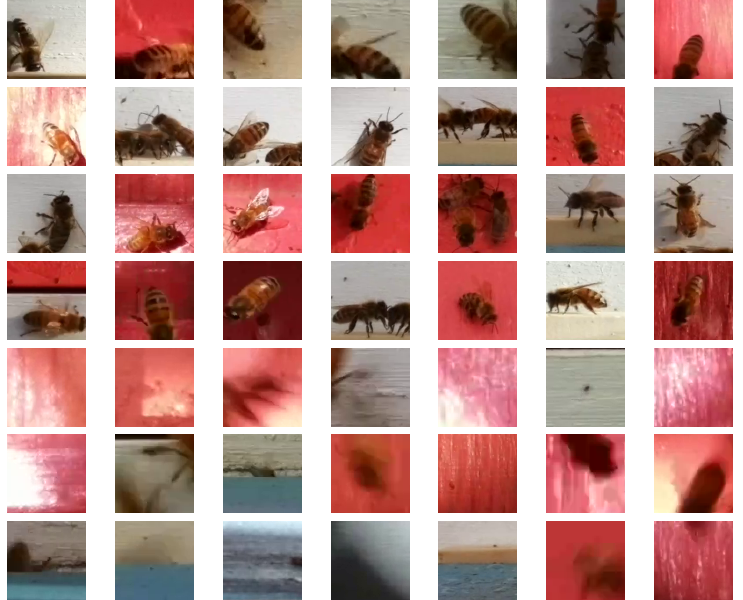
Figure 6. Sample of 1-super images from BEE2 (BEE2_1S) we used in [9]; the first four rows include images classified as BEE; the last three rows consist of images classified as NO_BEE.